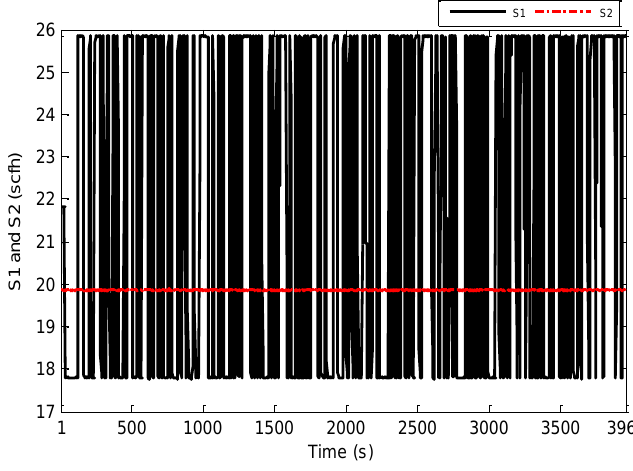
Figure 5. PRBS test - input S1 and S2 (scfh).